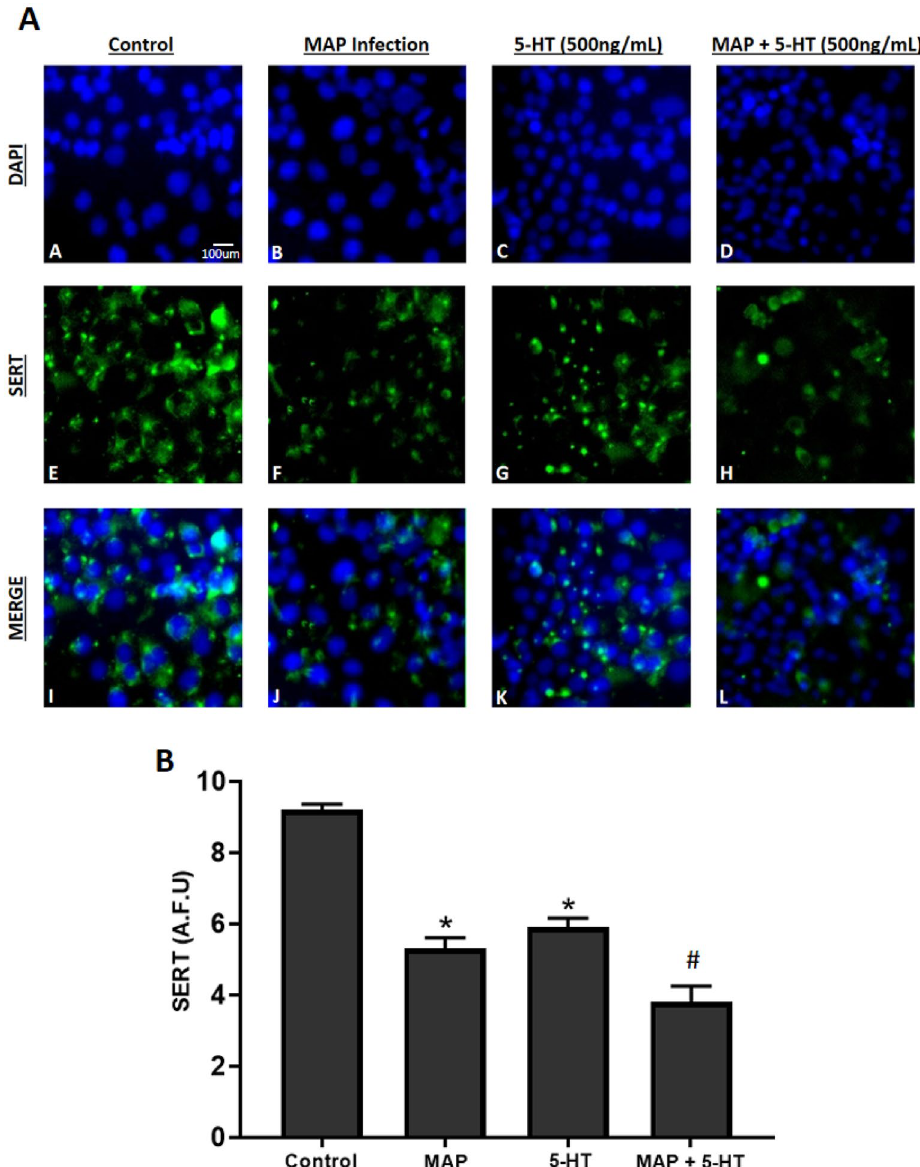
Figure 4. ( A ) Effect of MAP infection on SERT protein level in Caco-2 monolayers in the presence of excess level (500 ng/mL) of 5-HT following 24 h of incubation. Total nuclei are stained with DAPI in blue ( A – D ). SERT positive cells are stained in green ( E – H ), and merged cells are presented in pink ( I – L ). ( B ) Quantitative corrected SERT fluorescence integrated density from control and treated groups. Values were pre-tested for normal distribution using the Kolmogorov–Smirnov normality test. Significance among experiments was assessed by two-way analysis of variance (ANOVA) followed by Bonferroni correction test. All SERT fluorescence staining experiments were performed in triplicates. Data are presented as Mean ± SD. * P value < 0.05 compared to no treatment control. # P value < 0.05 compared to no treatment control, MAP, and 5-HT